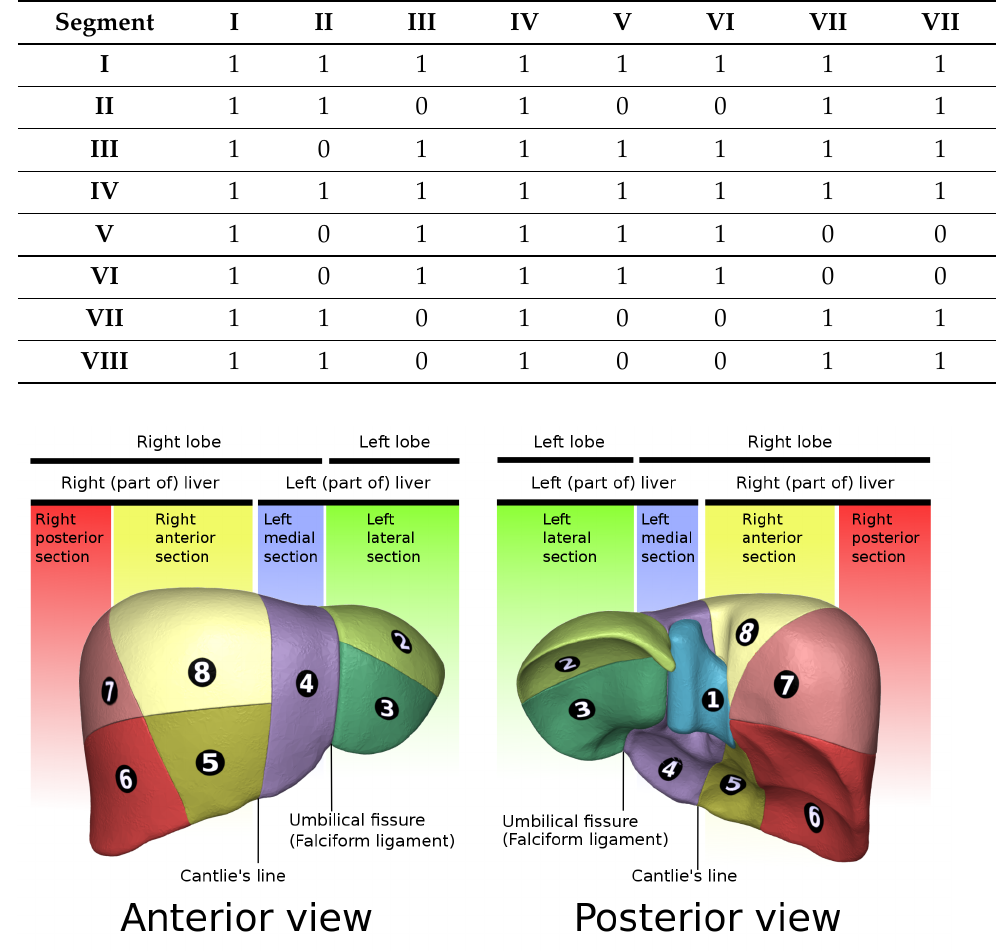
Figure 4. Liver segments’ anatomy. Data generated by the Database Center for Life Science